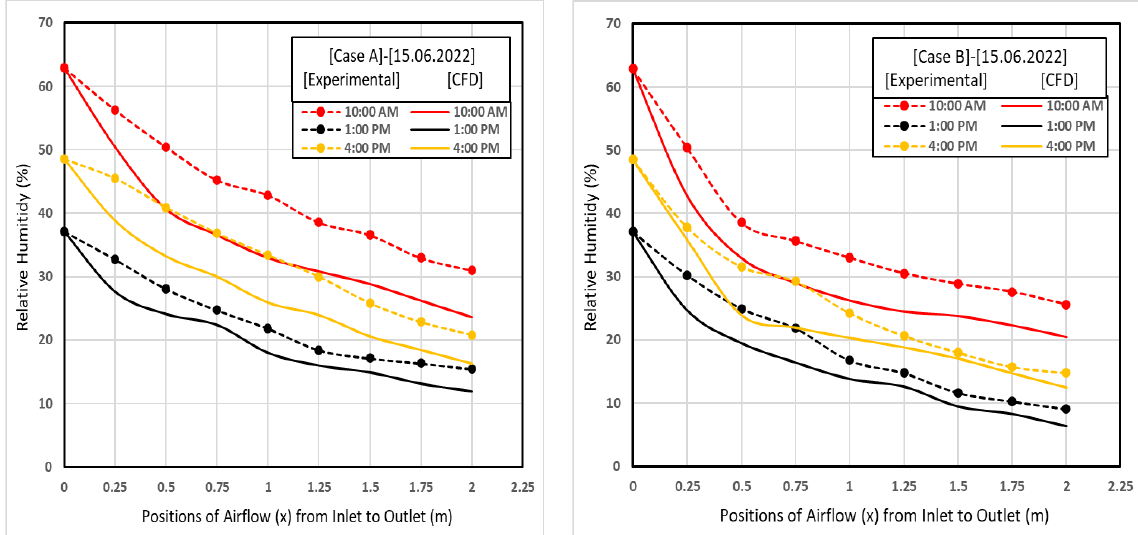
Figure 16. CFD validation of the airflow’s relative humidity variation and the experimental data for the Case A and Case B FPSAHs tested at various time